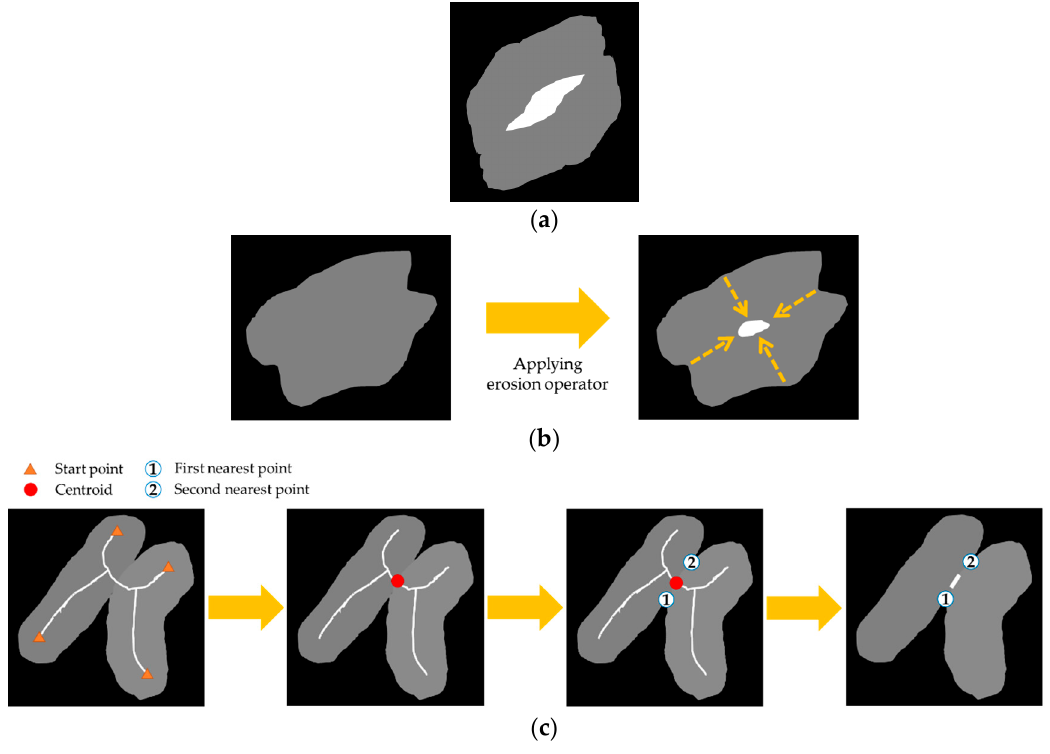
Figure 10. Illustration of natural and artificial holes: ( a ) natural hole; ( b ) artificial hole using erosion operator; ( c ) artificial hole using skeleton operator.